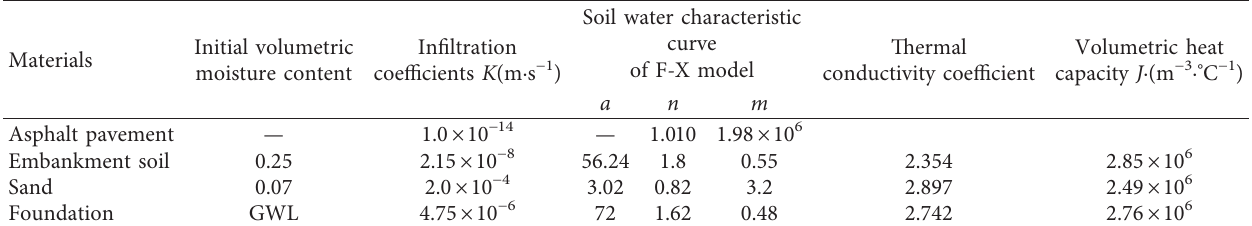
Figure 5: (a) Soil water characteristic curves and (b) hydraulic conductivity functions of embankment soil and sand. Table 1: Hydraulic and thermal property parameters of embankment